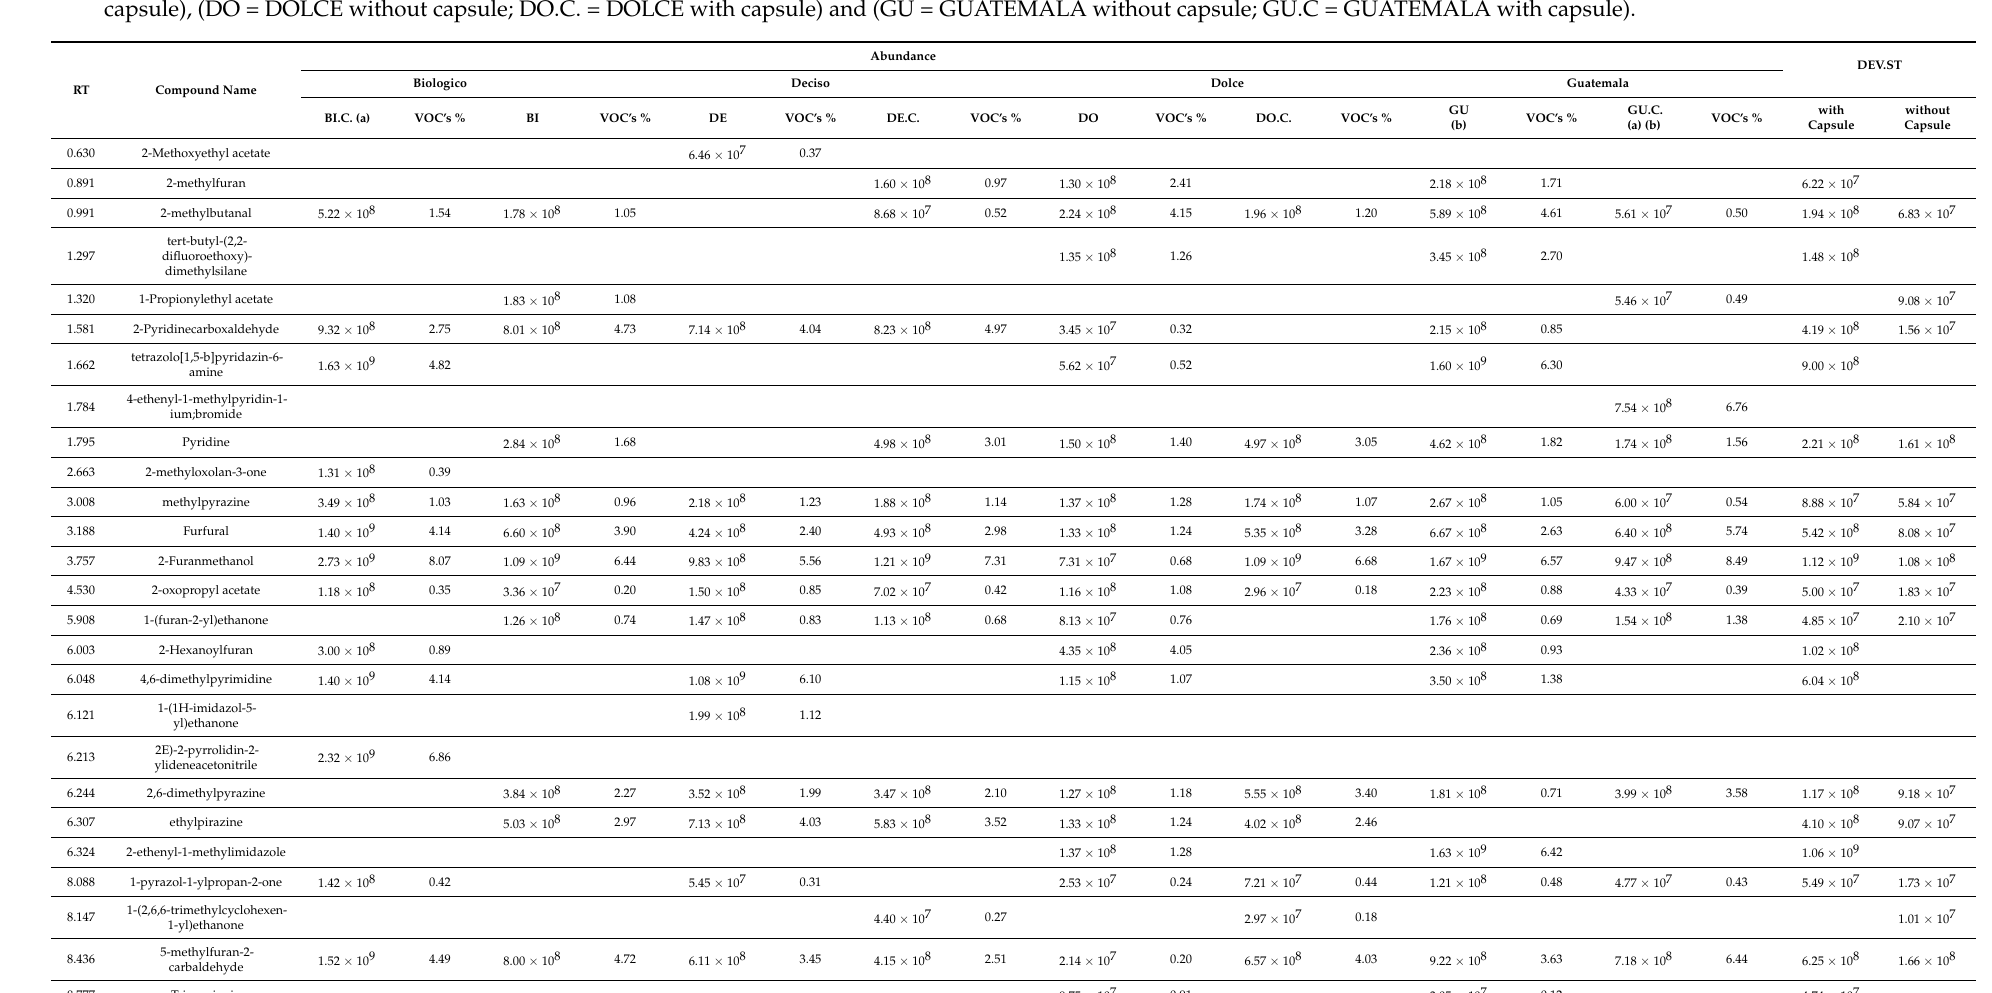
Table 1. Table of compounds regarding the means of the three replicates for each sample performed with the GC–MS analysis. Significant differences after Tukey’s test are highlighted with (a) for the Biologico (capsule)—Guatemala (no capsule) with a p value of 0.0032 and (b) for Guatemala (capsule)-Guatemala (no capsule) with a p value of 0.0289, also indicating the percentage of presence of each compound in each sample. (BI = BIOLOGICO without capsule; BI.C. = BIOLOGICO with capsule), (DE = DECISO without capsule; DE.C = DECISO with capsule), (DO = DOLCE without capsule; DO.C. = DOLCE with capsule) and (GU = GUATEMALA without capsule; GU.C = GUATEMALA with